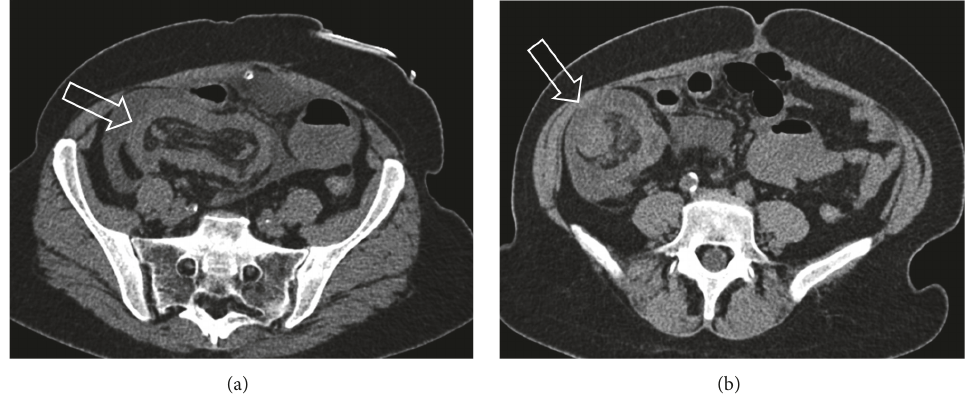
Figure 11: CT scan images showing ileocecal intussusception (arrows) from a 2cm neuroendocrine tumor arising from the terminal